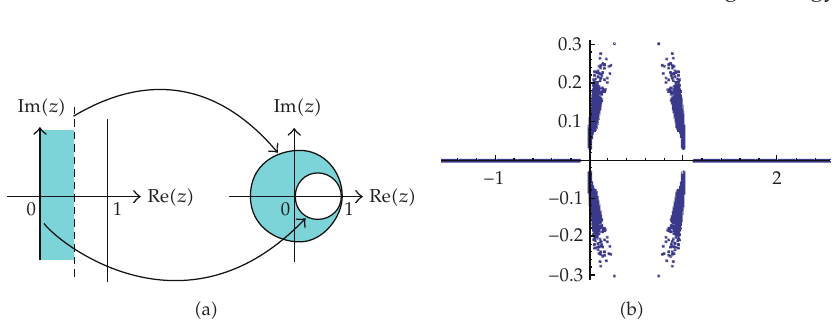
Figure 3: (cid:5) a (cid:6) The conformal map z → (cid:5) z/ (cid:5) z − 1 (cid:6)(cid:6) takes the left half of the critical strip to the inside of the unit disk, with the boundaries mapped as shown by the arrows. It takes the mirror image, in the right half of the critical strip, to the complement of the unit disk. The inverse map is given by z → (cid:5) z/ (cid:5) z (cid:8) 1 (cid:6)(cid:6) . (cid:5) b (cid:6) The position of 50000 randomly integer monic palindromic sextic polynomials with vanishing linear/quintic terms and with coe ffi cients ranging in (cid:3) 0 , 1000 (cid:4) , applying the map z → (cid:5) z/ (cid:5) z (cid:8) 1 (cid:6)(cid:6)